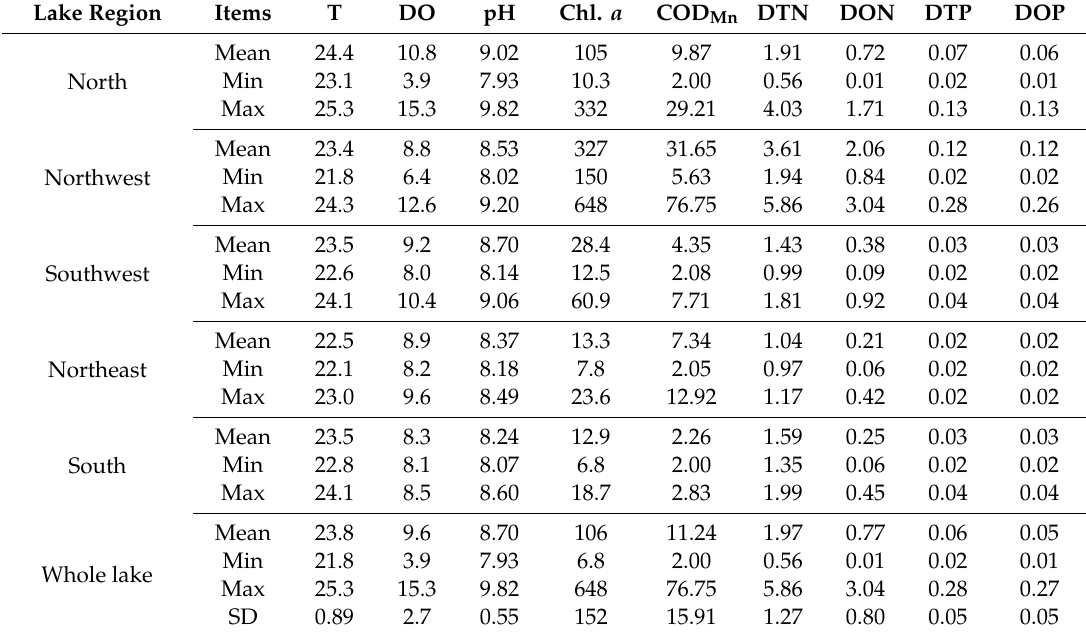
Table 1. Basic physical-chemical indices of the overlying water of Taihu Lake. Units: mg / L = dissolved oxygen (DO), permanganate index (COD Mn ), dissolved total nitrogen (DTN), dissolved organic nitrogen (DON), dissolved total phosphorus (DTP), and dissolved organic phosphorus (DOP) contents; ◦ C = T; mg / m 3 = chl. a